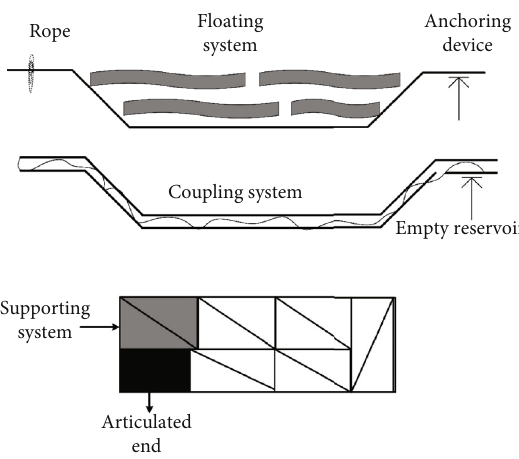
Figure 3: Structural design of fl oating photovoltaic (FPV)